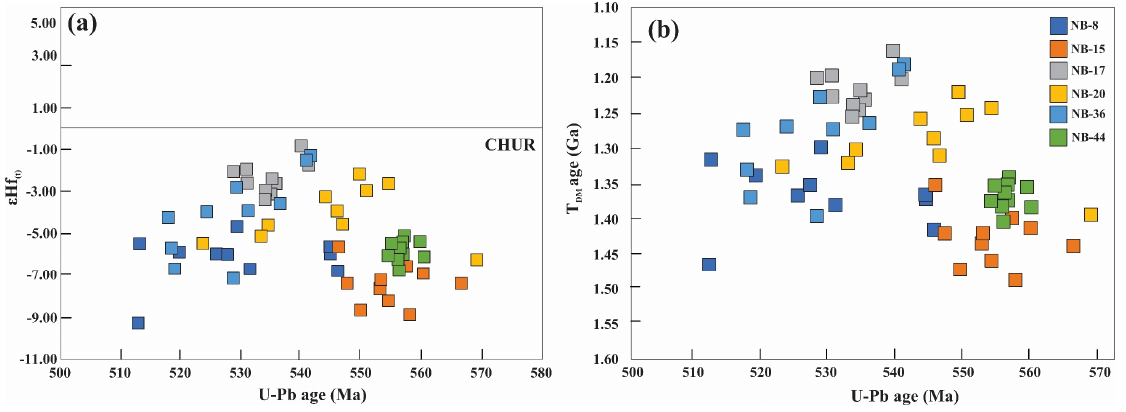
Figure 11. ( a ) Age vs. ε Hf(t) of zircons; ( b ) U-Pb age diagram vs. T DM age. Legend given in Figure 11b.